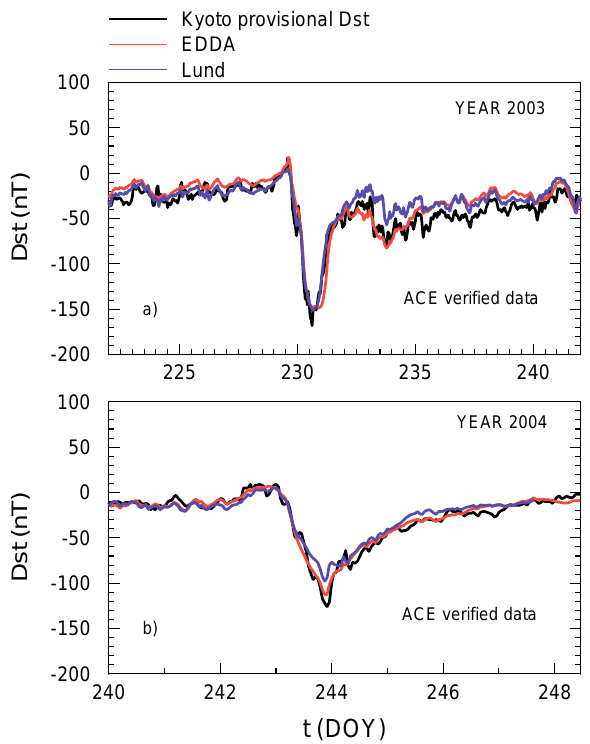
Fig. 5. Comparison of the EDDA (red line) and “Lund” D st (blue line) with the Kyoto D st (black line) for two “intense” storms.